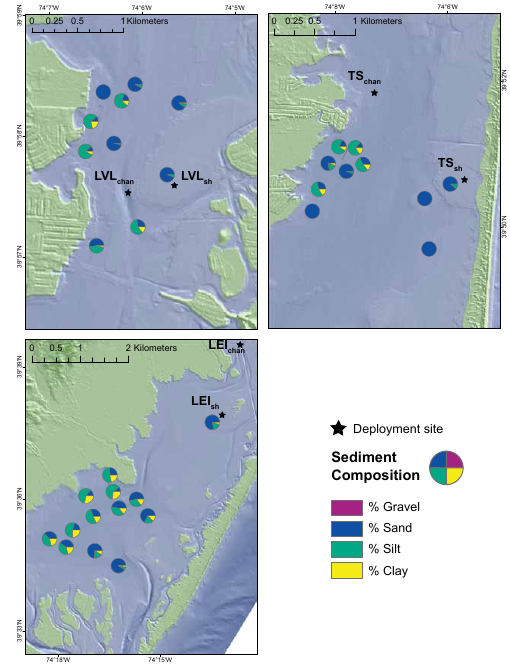
Figure 7. Surficial sediment composition adjacent to deployment sites. A higher abundance of clay-sized sediment is available near site LEI as compared to the other